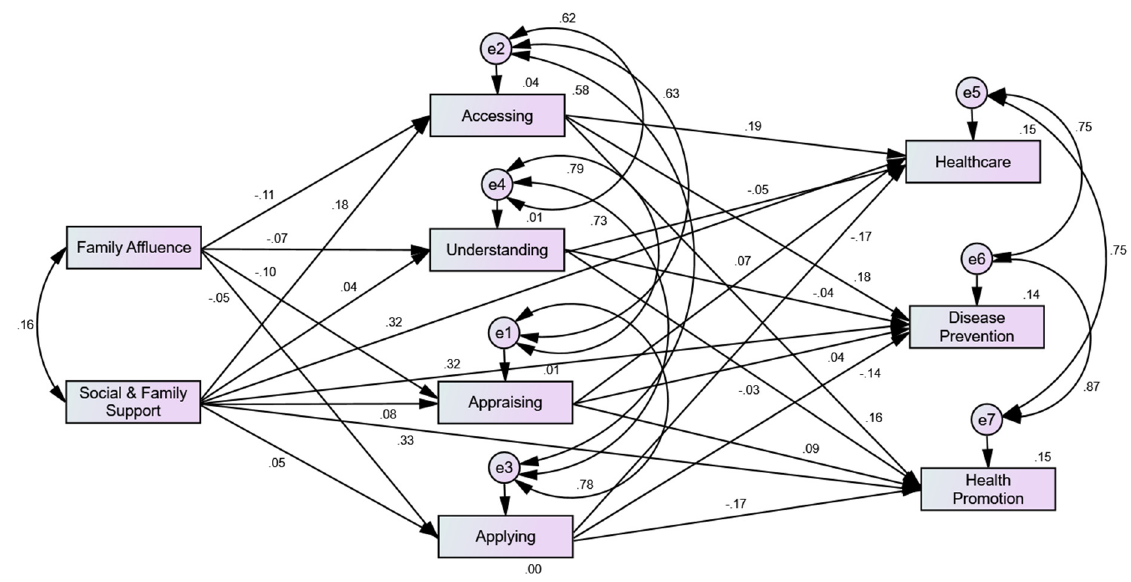
Figure 4. Structural equation model estimating the direct and indirect effects .